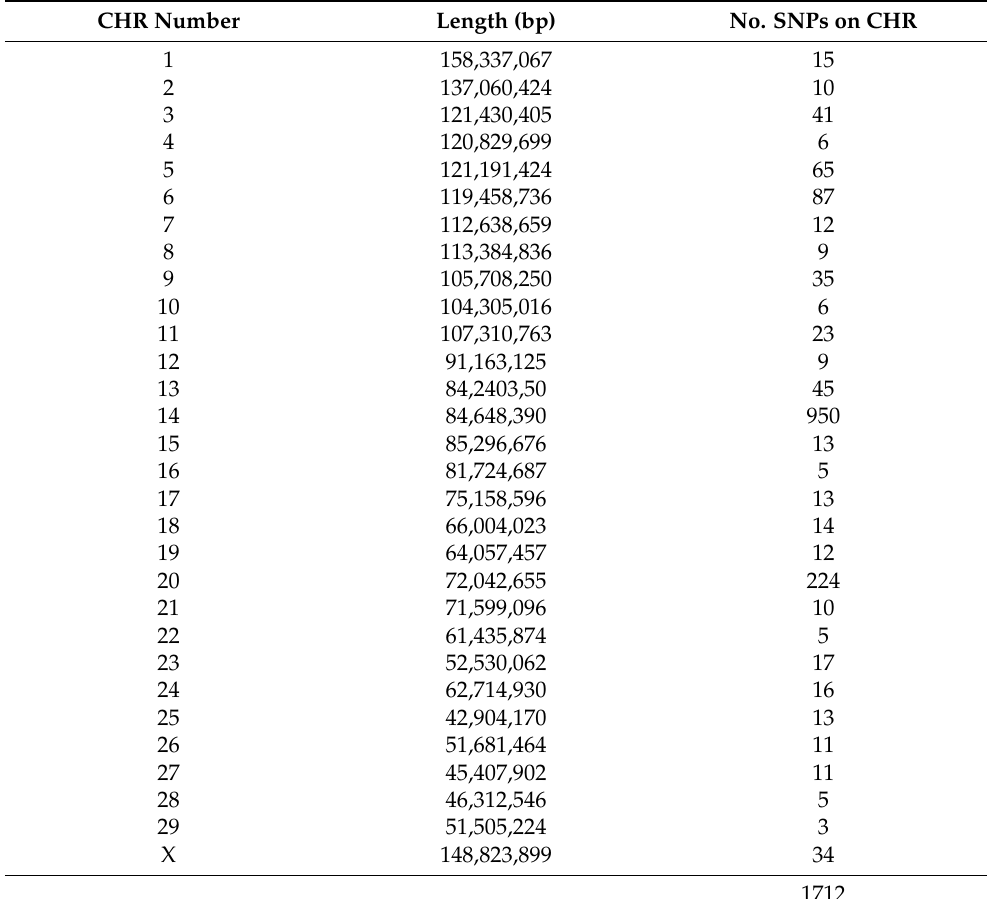
Table 1. The length of each chromosome and number of effective SNPs on them.